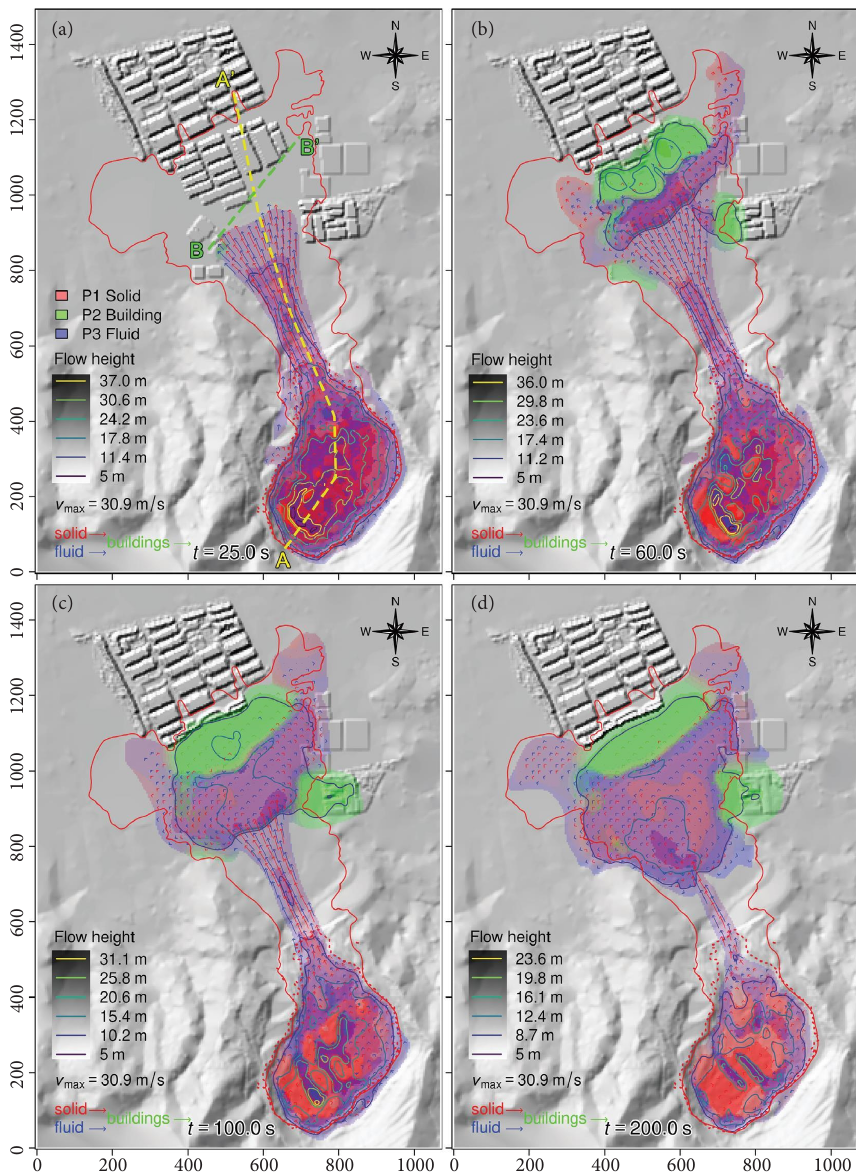
Figure 6: Te morphological characteristics of the landslide in simulation (I) considering the entrainment of buildings. Te yellow dashed line represents the profle line along which the fow depth and velocity features in the simulation will be extracted. Te green dashed line marks the leading edge of the north side of the destroyed buildings. Te red dashed circle in (d) marks a local area for comparison between